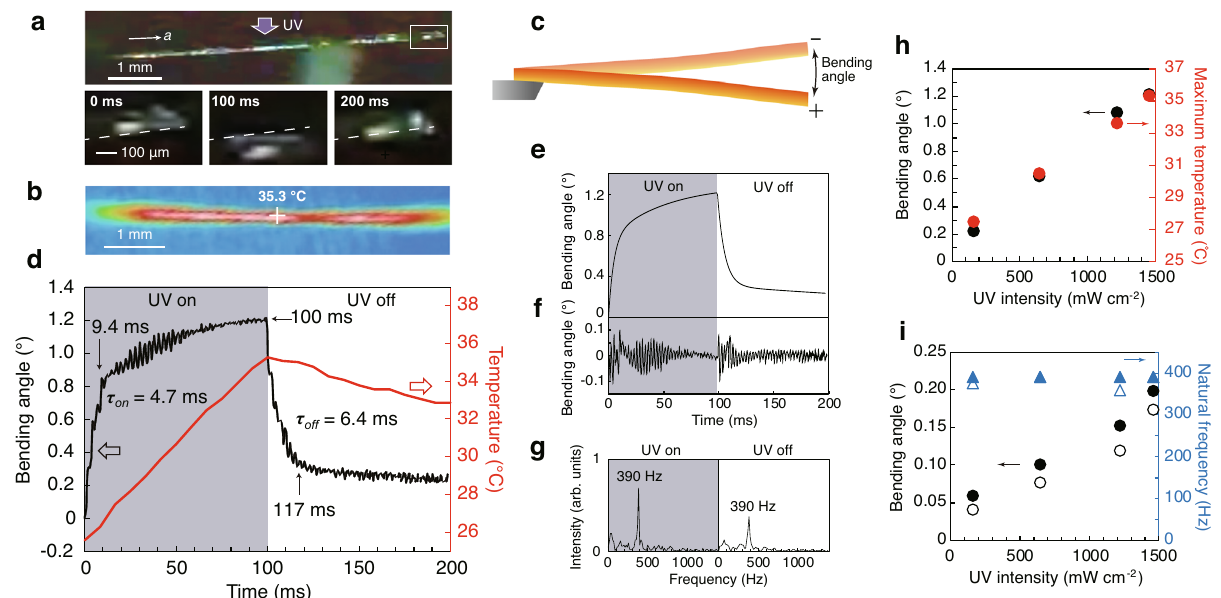
Fig. 2 | Bending behaviour of 1 β crystal III by the photothermal effect and the naturalvibration(390Hz)byirradiationwithUVlight(375nm,1456mWcm − 2 ). a Side view photo of a hexagonal rod-shaped crystal with the left end fi xed to the glass needle, and the sequential snapshots of tip displacement before (left), upon (middle), and after (right) UV irradiation. b Temperature distribution of the irra- diatedcrystalsurfaceunderUVirradiationfor100ms.Thecrossmarkindicatesthe measuredtemperaturepoint. c De fi nitionofthebendingangleofthephotothermal bendingandthenaturalvibration. d Timedependenceofthebendingangle(black) and the maximumtemperature(red)ofthe irradiated surface withand without UV